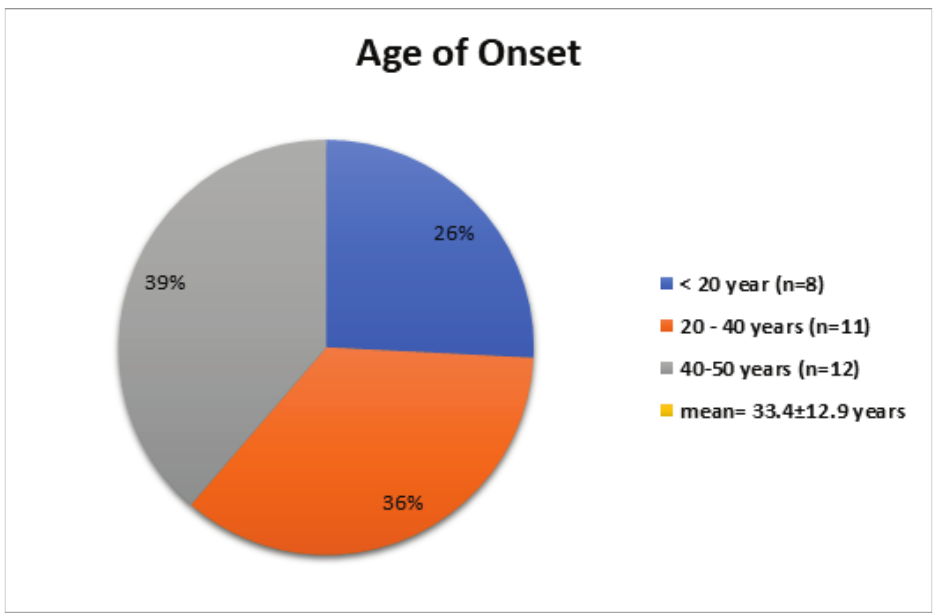
Figure 3: Gender distribution among study group ( n = 31)The age of onset of PINK1 type early onset PD ( n = 31).